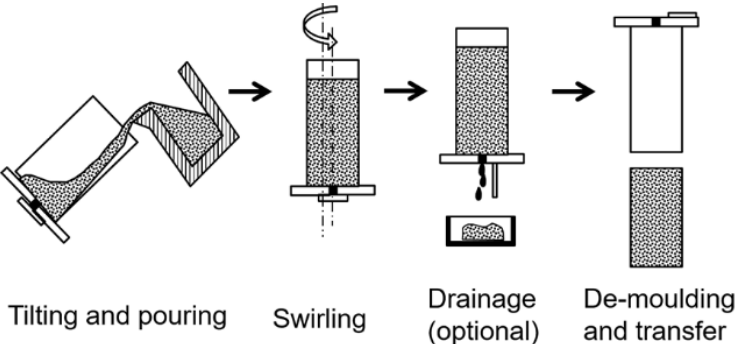
Figure 12. Schematic diagram of the SEED process. Reprinted with permission from Ref. [133]. Copyright 2006 SAE International.